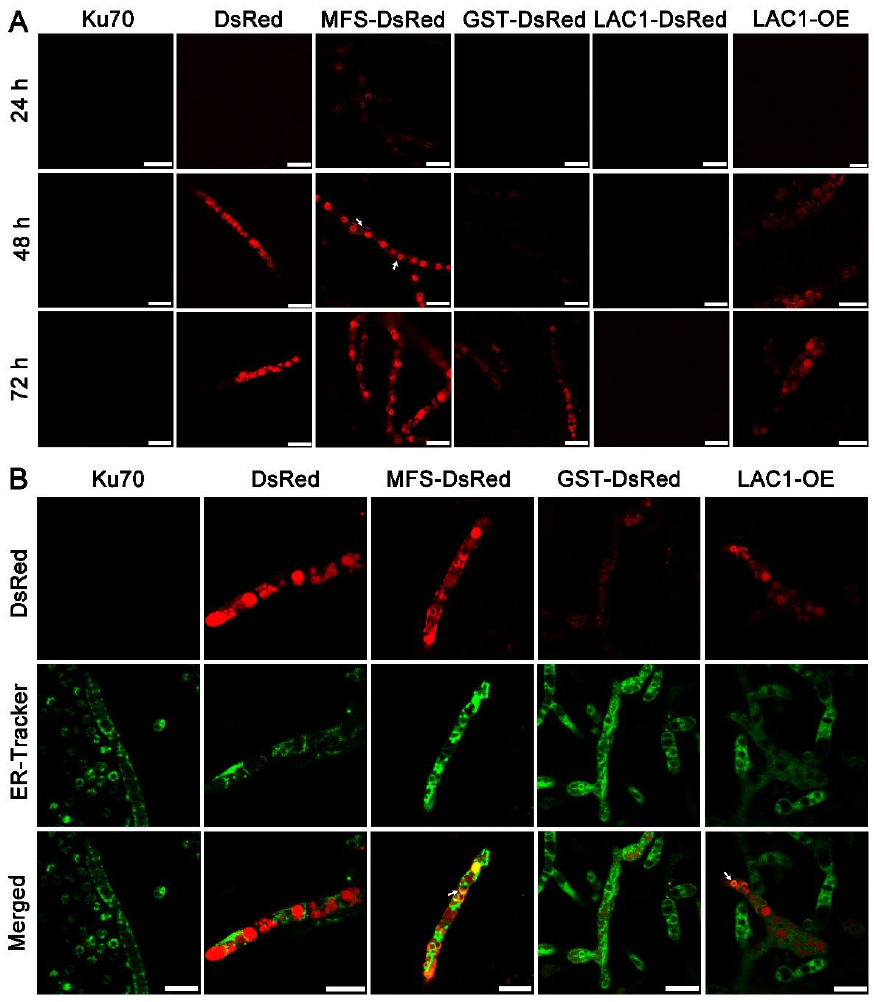
Figure 5. ( A ) Cellular localization of the three sugar transporters in T. reesei cultured in TMM + 2% lactose at 24 h, 48 h, and 72 h, respectively. The white arrow indicates the localization of MFS-DsRed on the cell membrane. ( B ) Confocal images of strains Δ ku70, DsRed, MFS-DsRed, GST-DsRed, LAC1-DsRed, and LAC1-DsRed-OE (LAC1-OE) with the treatment of ER-Tracker (green). Strains MFS-DsRed and GST-DsRed were constructed under their own endogenous promoters, and strain LAC1-DsRed-OE was constructed under the modified strong promoter cbh1.The white arrow points to the overlap of the green ER dye with the red fluorescent protein fusion LAC1-DsRed-OE. Scale bar = 10 μm.